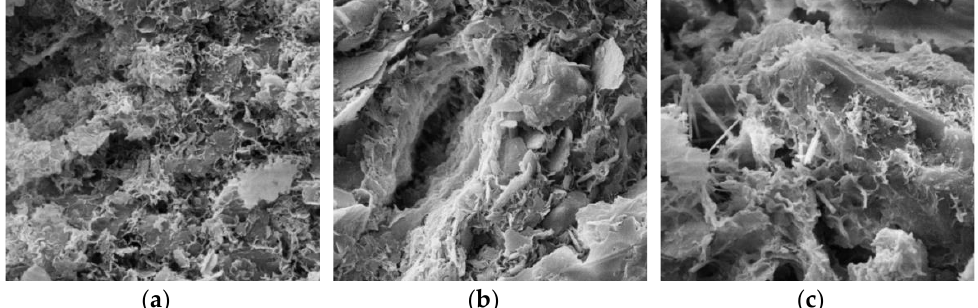
( c ) Figure 5. Relationship of q u - A w with C o = 7.7% at different T . ( a ) T = 18 °C ; ( b ) T = 36 °C ; ( c ) T = 46 °C . Figure 6 shows SEM images with different C HA . Compared with the CSC without HA ( C HA = 0%), the sample with HA ( C HA = 4%) shows a lower density. Although the pore size of the sample doped with HA ( C HA = 4%) is relatively high, hydration products can also be observed around the clay particles, which are mutually cemented with the soil particles and improve the strength of CSC. However, with the increase of organic matter content